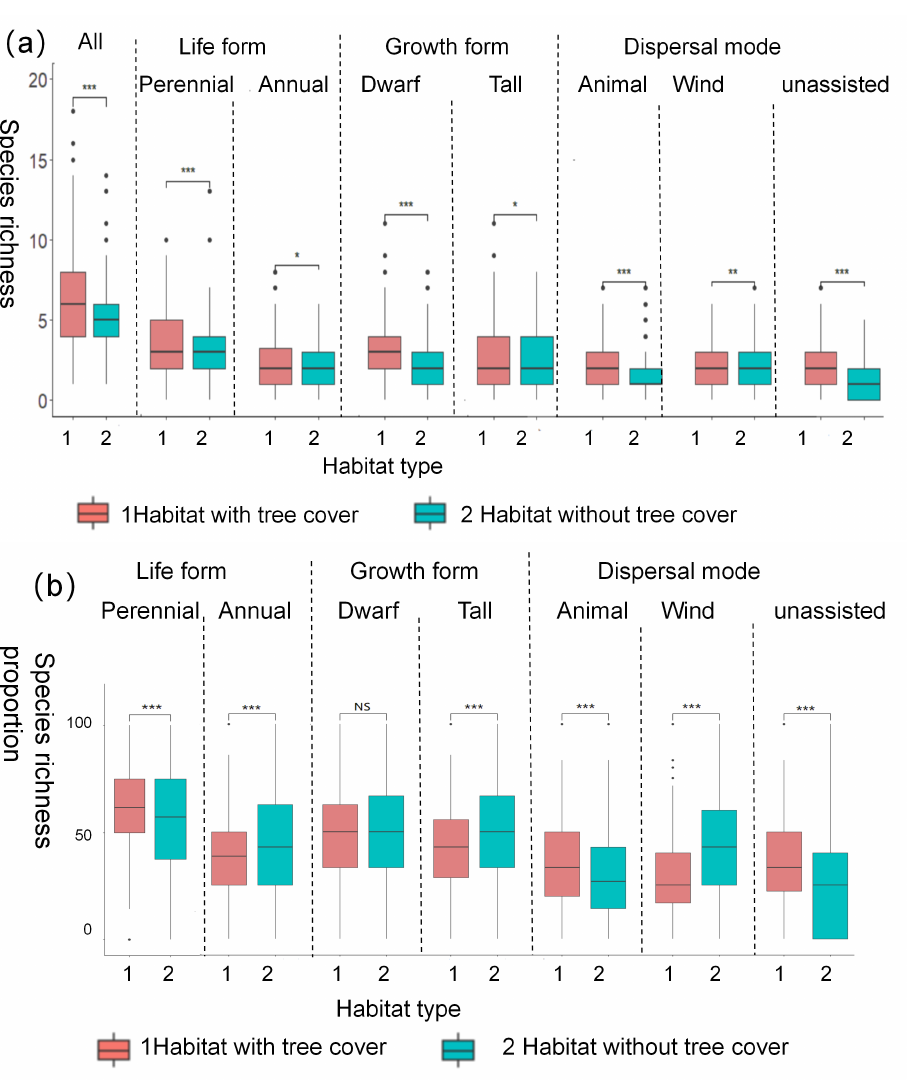
Figure 2. Difference in the species richness (proportion) between habitats with and without tree cover ( a ) species richness. ( b ) species richness proportion.(Characters (NS) indicate no significant difference. Asterisks (*) indicate significance at p < 0.05, asterisks (**) indicate significance at p < 0.01, asterisks (***) indicate significance at p <